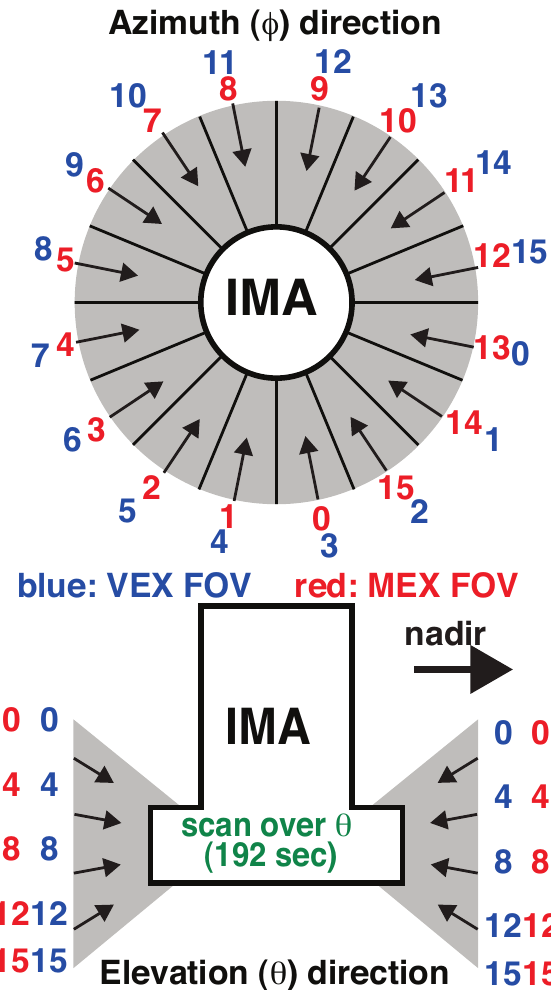
Fig. 2. Definition of field-of-view directions ( θ and φ ) of IMA for both Venus Express (blue) Mars Express (red). The azimuthal sector numbers ( φ ) are given in the upper panel, and the elevation numbers ( θ ) are given in the lower panel.